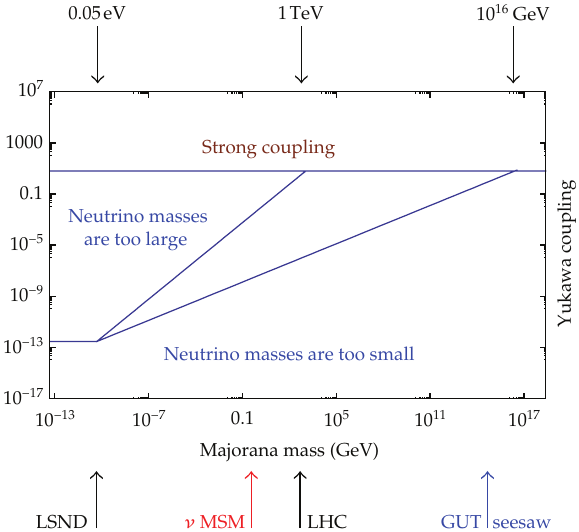
Figure 2: The admitted values of the Yukawa couplings of sterile neutrinos as a function of their seesaw Majorana